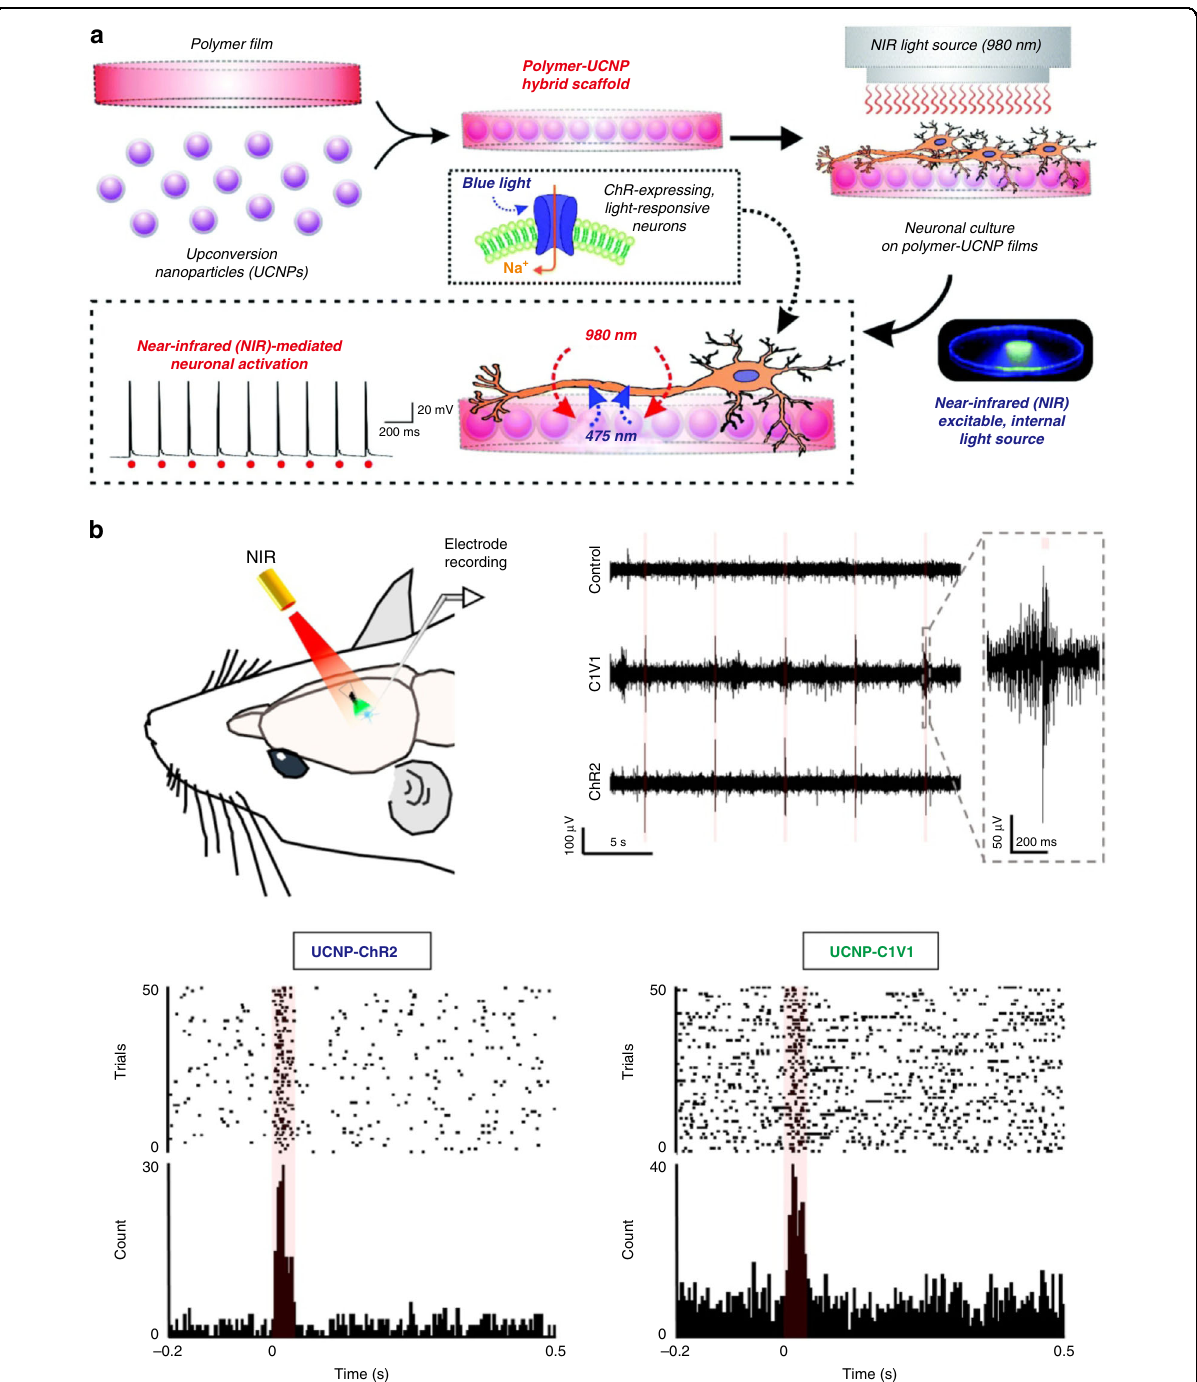
Fig. 10 Rare-earth based materials-mediated optogenetics in neuron and mice models. a In vitro neuron model of NIR light-induced optogenetics with polymer-UCNPs hybrid scaffolds. The UCNPs emitted blue light to activate ChR2-expressing neurons under NIR irradiation. Reprinted with permission from ref. 107 . Copyright 2015 The Royal Society of Chemistry. b In vivo mice model of UCNPs-mediated optogenetics. The UCNPs-optrode was implanted into a mouse brain and excited through pulsed NIR to record the neuron activities in both ChR2- and C1V1- expressing cells. Reprinted with permission from ref. 111 . Copyright 2017